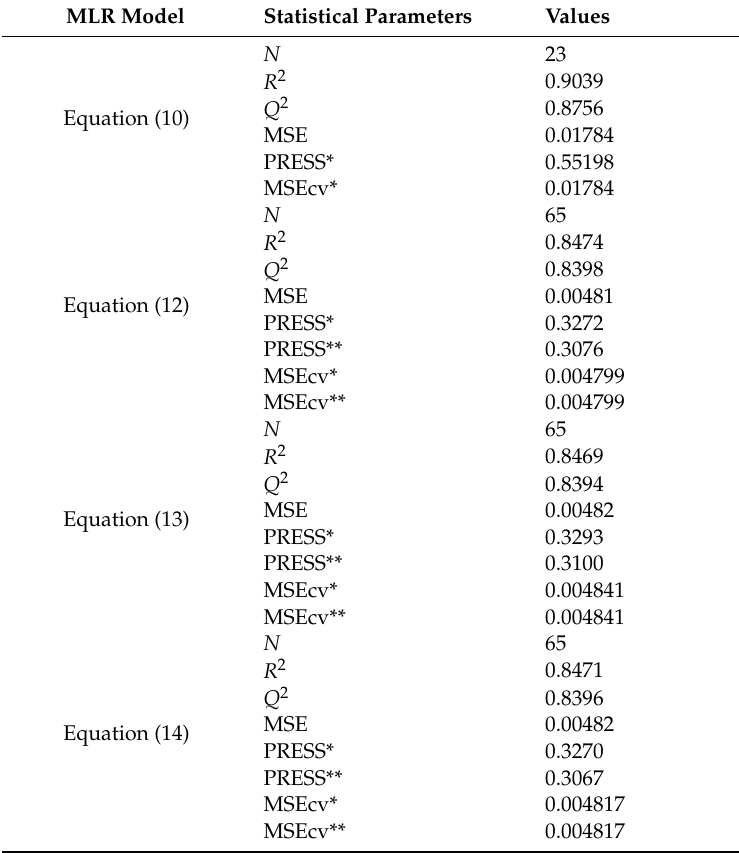
Table 4. Statistical parameters of cross-validation of MLR models described by Equations (10), (12), (13) and (14); MSE—mean square error, MSEcv*—mean square error of leave-one-out cross